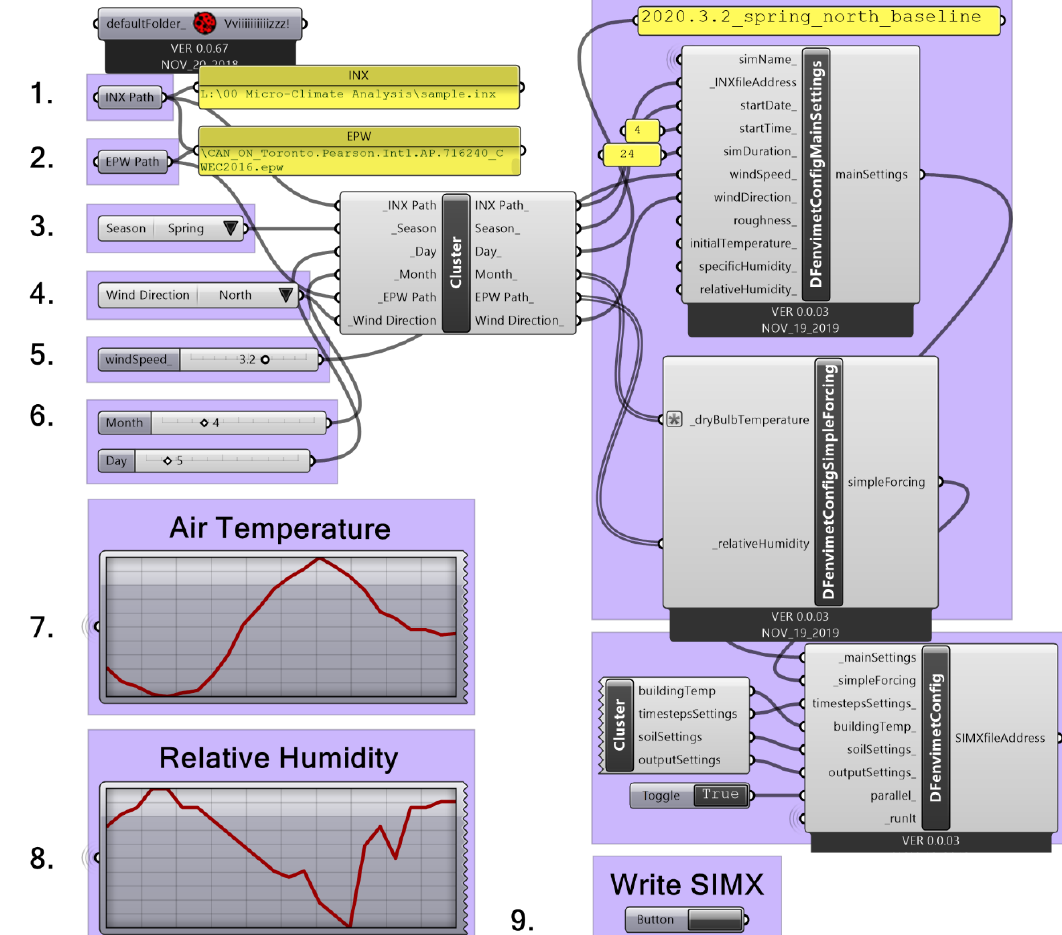
Figure 2. A Grasshopper script which uses Ladybug and df_envimet components to e ffi ciently set up meteorological boundary conditions for